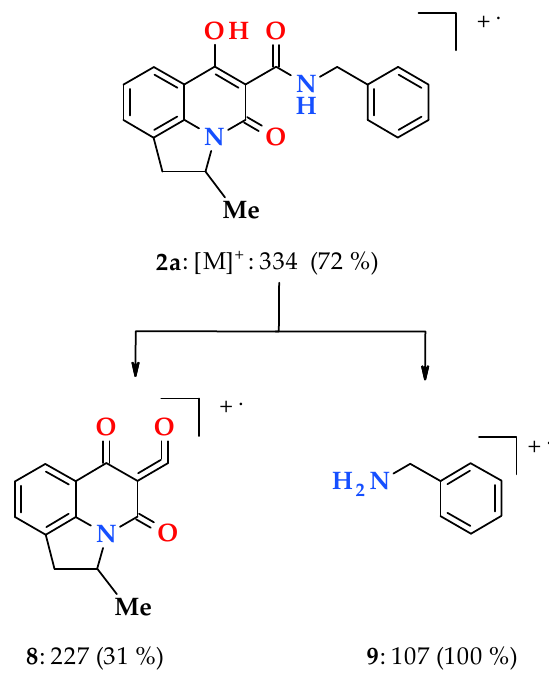
Scheme 2. The primary fragmentation of the molecular ion of benzylamide 2a